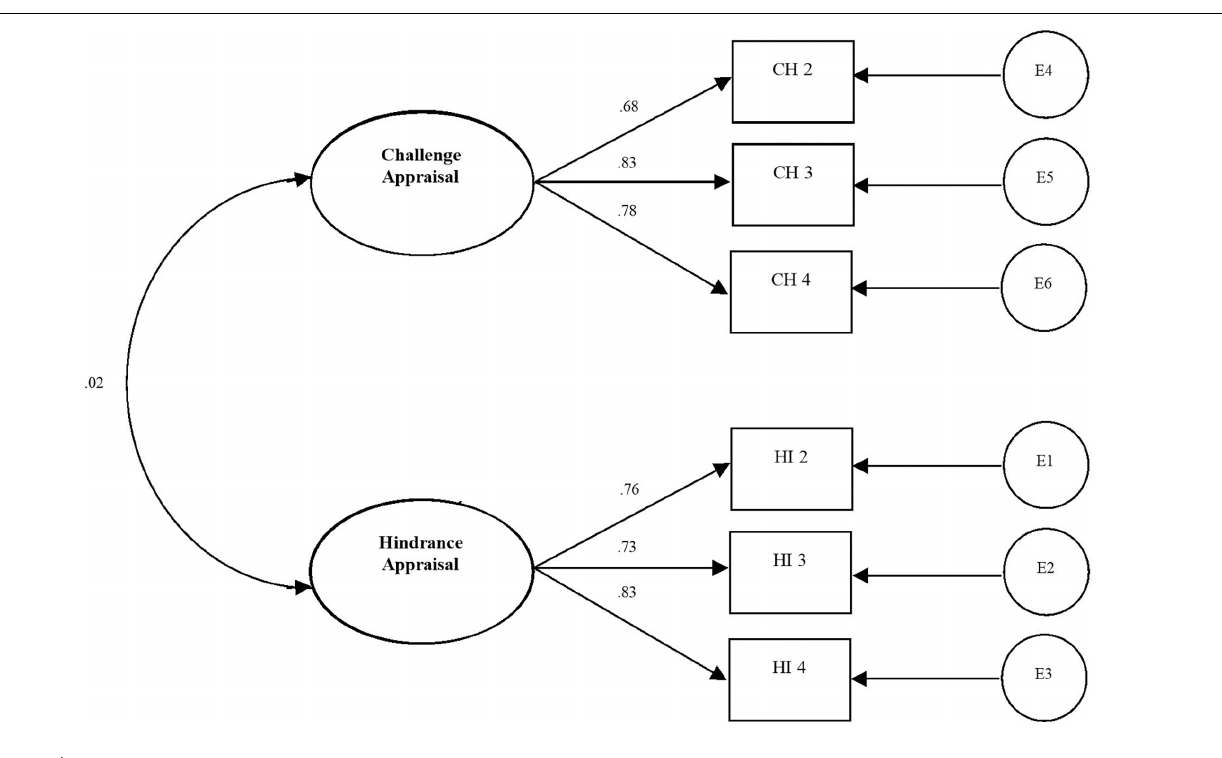
FIGURE 2 | A measurement model of the challenge-hindrance appraisal of job insecurity scale.